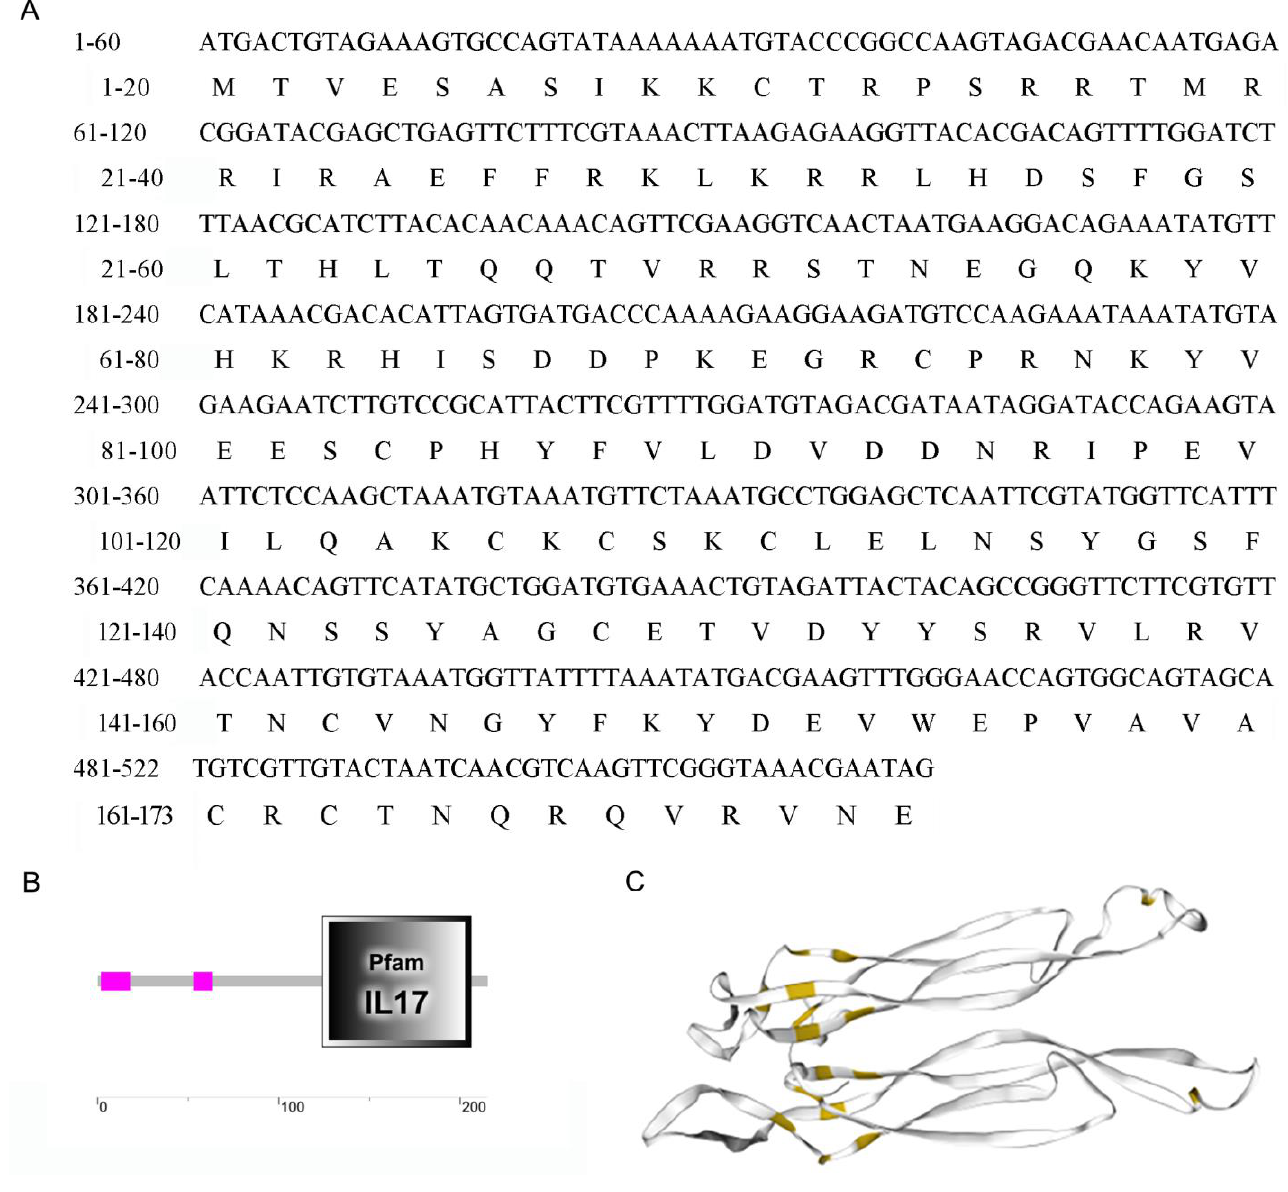
Figure 1. Molecular characterization of Mc IL17-1. ( A ) The nucleotide sequences and the deduced amino acid sequences of IL17-1 in thick shell mussel Mytilus coruscus . It contains a 585 bp ORF region coding the protein of 194 amino acid residues; ( B ) Schematic diagram of IL17 structure domain; ( C ) Schematic diagram of cysteine nodule structure (Yellow marked: cysteines).